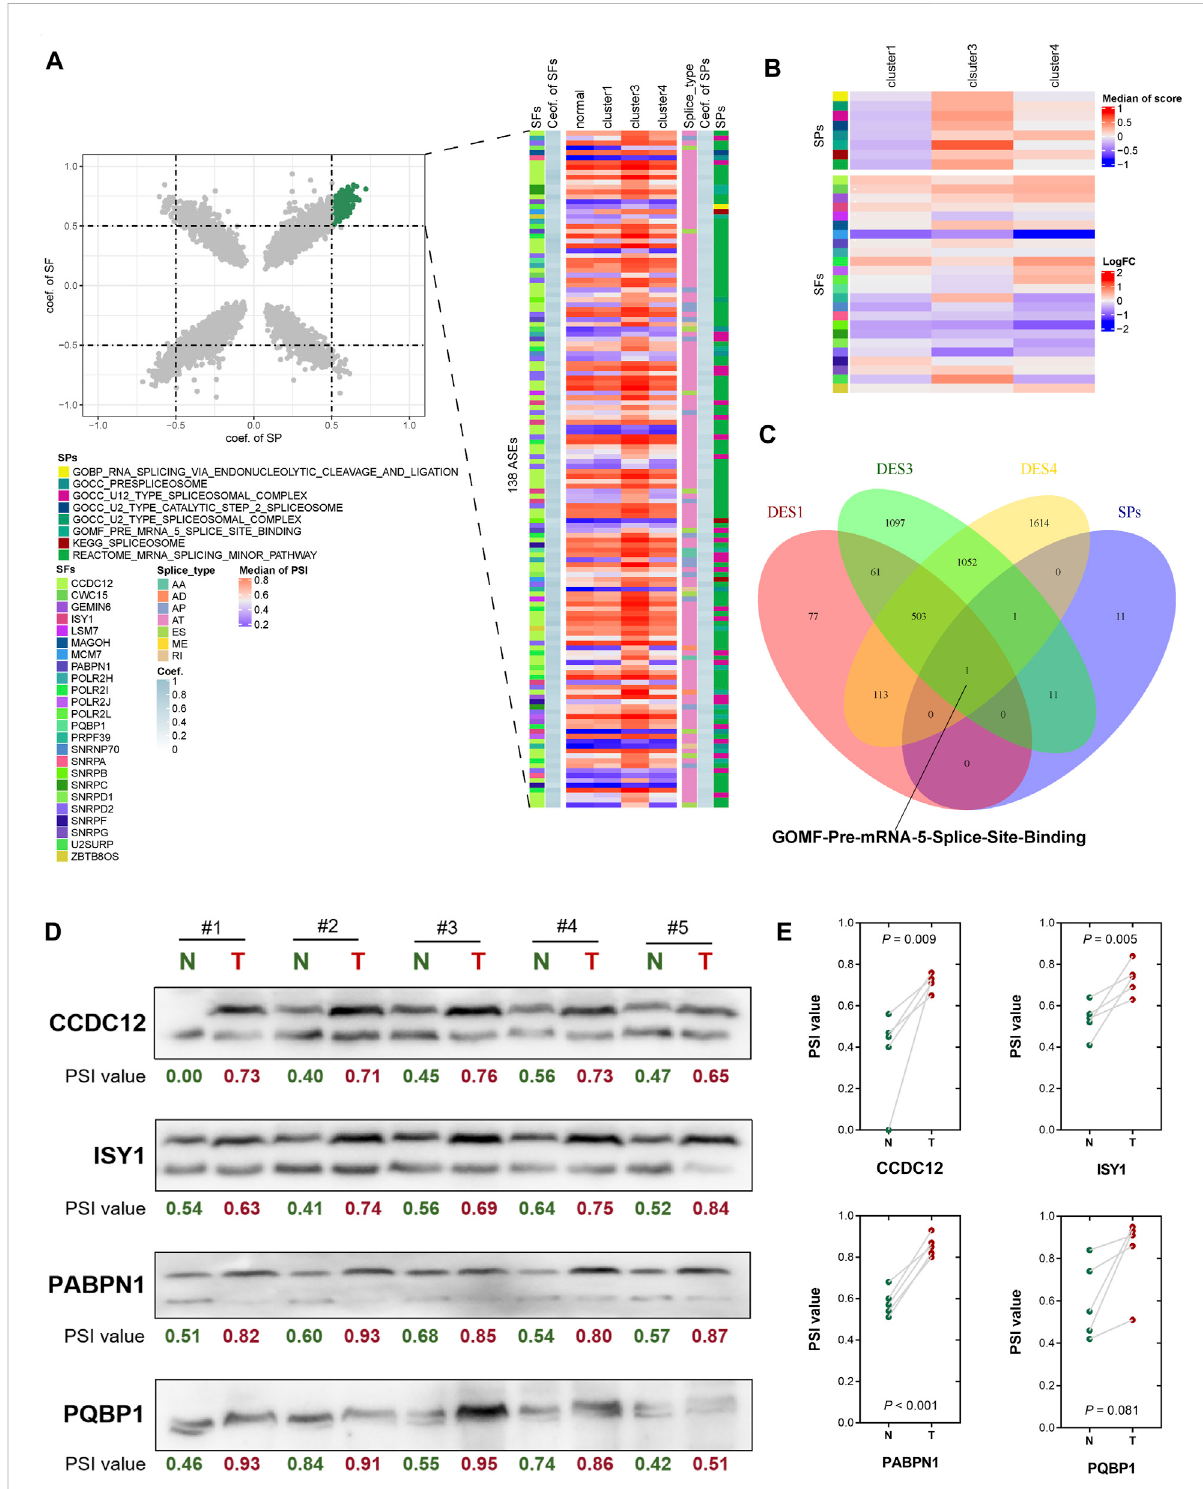
FIGURE 4 Correlation analysis of alternative splicing pathways, alternative splicing events and alternative splicing factors. (A) Scatter plot showing the association between alternative splicing events and SPs and SFs. (B) Heat map showing the association between alternative splicing events and SPs andSFs. (C) VenndiagramshowsthecommonpathwaysofSPsanddifferentialpathways. (D) DifferentiallyexpressedsplicingtranscriptsofCCDC12, ISY1, PABPN1 and PQBP1 were validated in human HCC tissues by RT-PCR and consequent agarose gel electrophoresis. PSI of each lane was calculated by the greyscale of the longer transcript divide the sum greyscale of the longer and the shorter transcripts. (E) Signi fi cance of difference between HCC tumor and adjacent normal tissues for splicing of CCDC12, ISY1, PABPN1 and PQBP1 were evaluated separately by two-tailed paired t